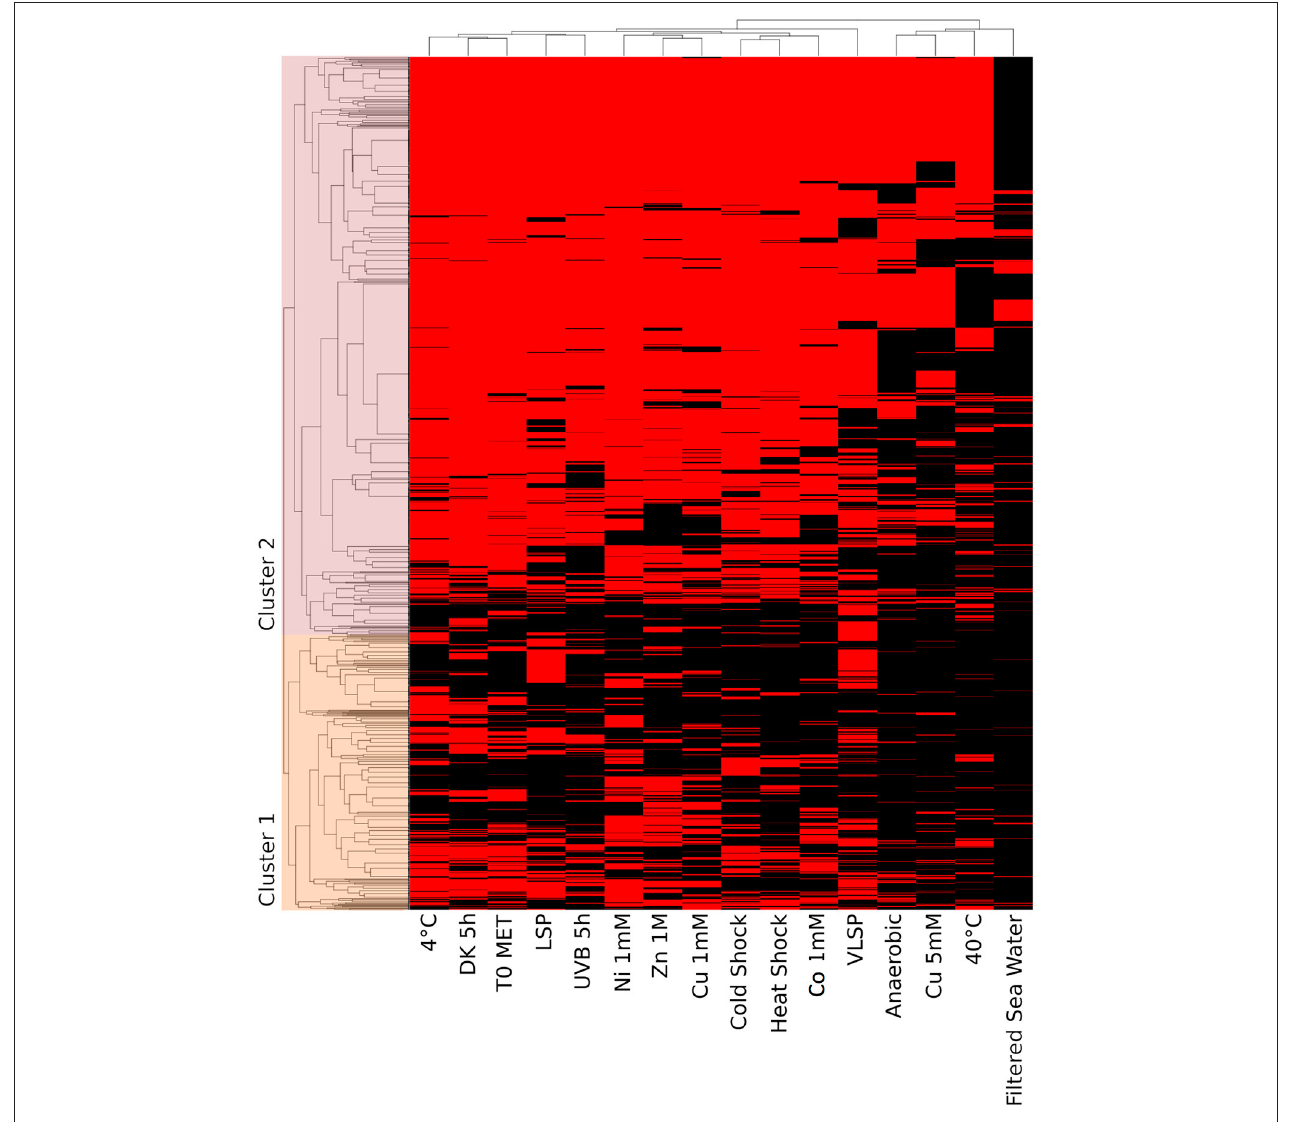
FIGURE 6 | Hierarchical cluster analysis (HCA) of the accessory proteome. The heat map is linked by a dendrogram representing clustering of the different experimental treatments (top), and protein expression profiles (side). Color code: Black: protein not identified/Red: protein identified by mass spectrometry.